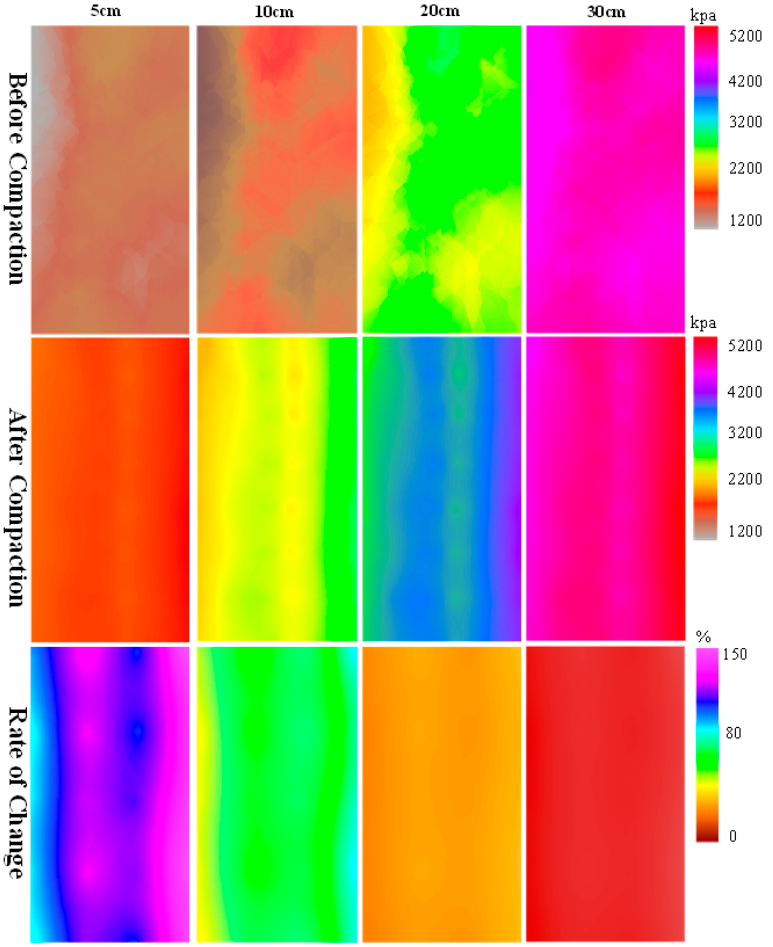
Figure 10. Transverse spatial distribution of soil compactness at each depth before and after com- paction.